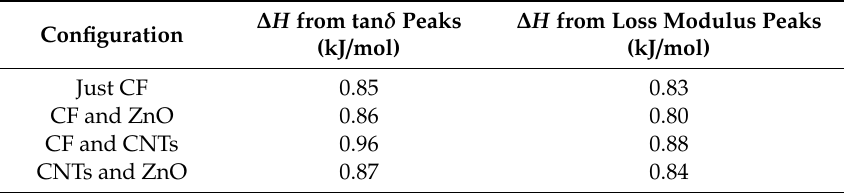
Table 4. Activation energy ( ∆ H ) values for the di ff erent composite